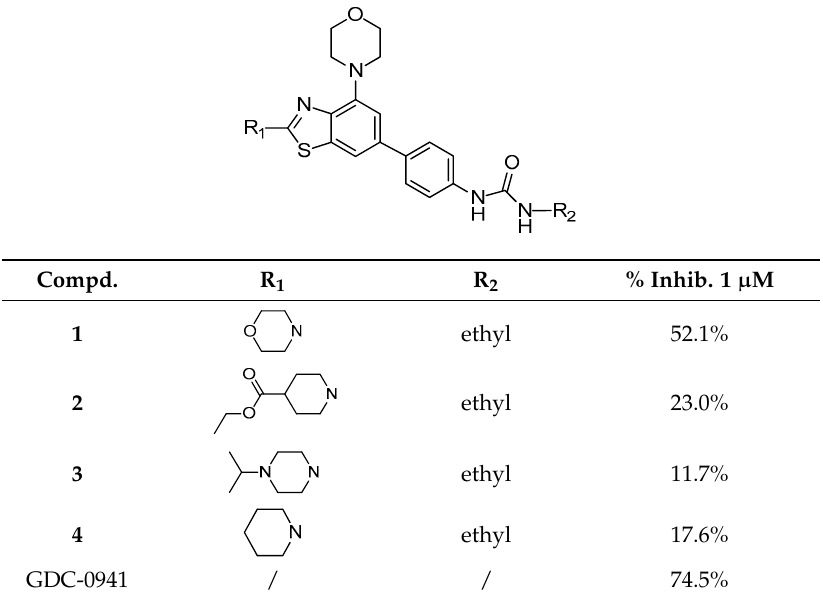
Table 1. Structures and inhibition rates of compounds 1 – 4 against PI3K β kinase at 1 μ M.